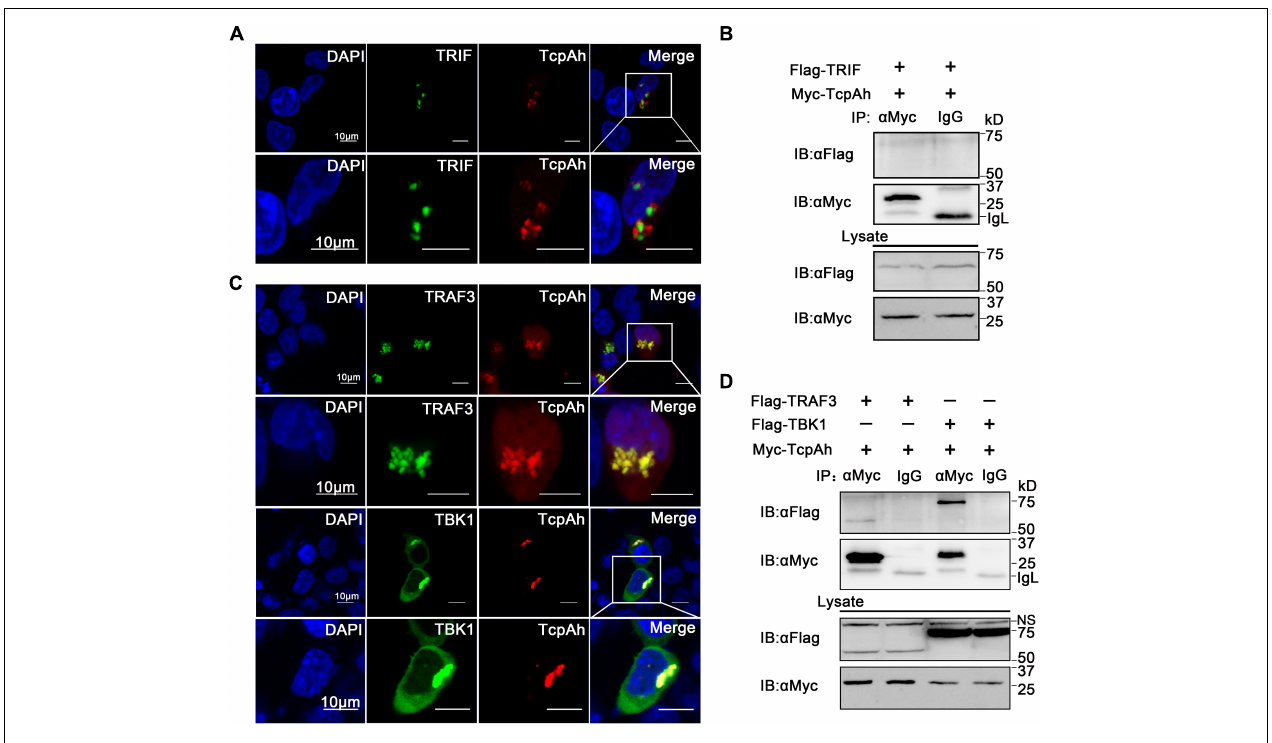
FIGURE 6 | Examination of the associations of TcpAh with TRAF3 and TBK1. (A) Co-localization analysis of TcpAh and zebrafish TRIF protein in HEK293T cells by confocal microscopy (Zeiss LSM 710; original magnification, 630 × ). The nucleus was stained with DAPI. Scale bars correspond to 10 µ m. (B) Co-IP analysis between TcpAh and zebrafish TRIF proteins from HEK293T cells expressing Myc-TcpAh with Flag-TRIF. (C) Co-localization analysis of TcpAh and zebrafish TRAF3 or TBK1 proteins in HEK293T cells by confocal microscopy (Zeiss LSM 710; original magnification, 630 × ). The nucleus was stained with DAPI. Scale bars correspond to 10 µ m. (D) Co-IP analysis between TcpAh and zebrafish TRAF3 or TBK1 proteins from HEK293T cells expressing Myc-TcpAh with Flag-TRAF3 or